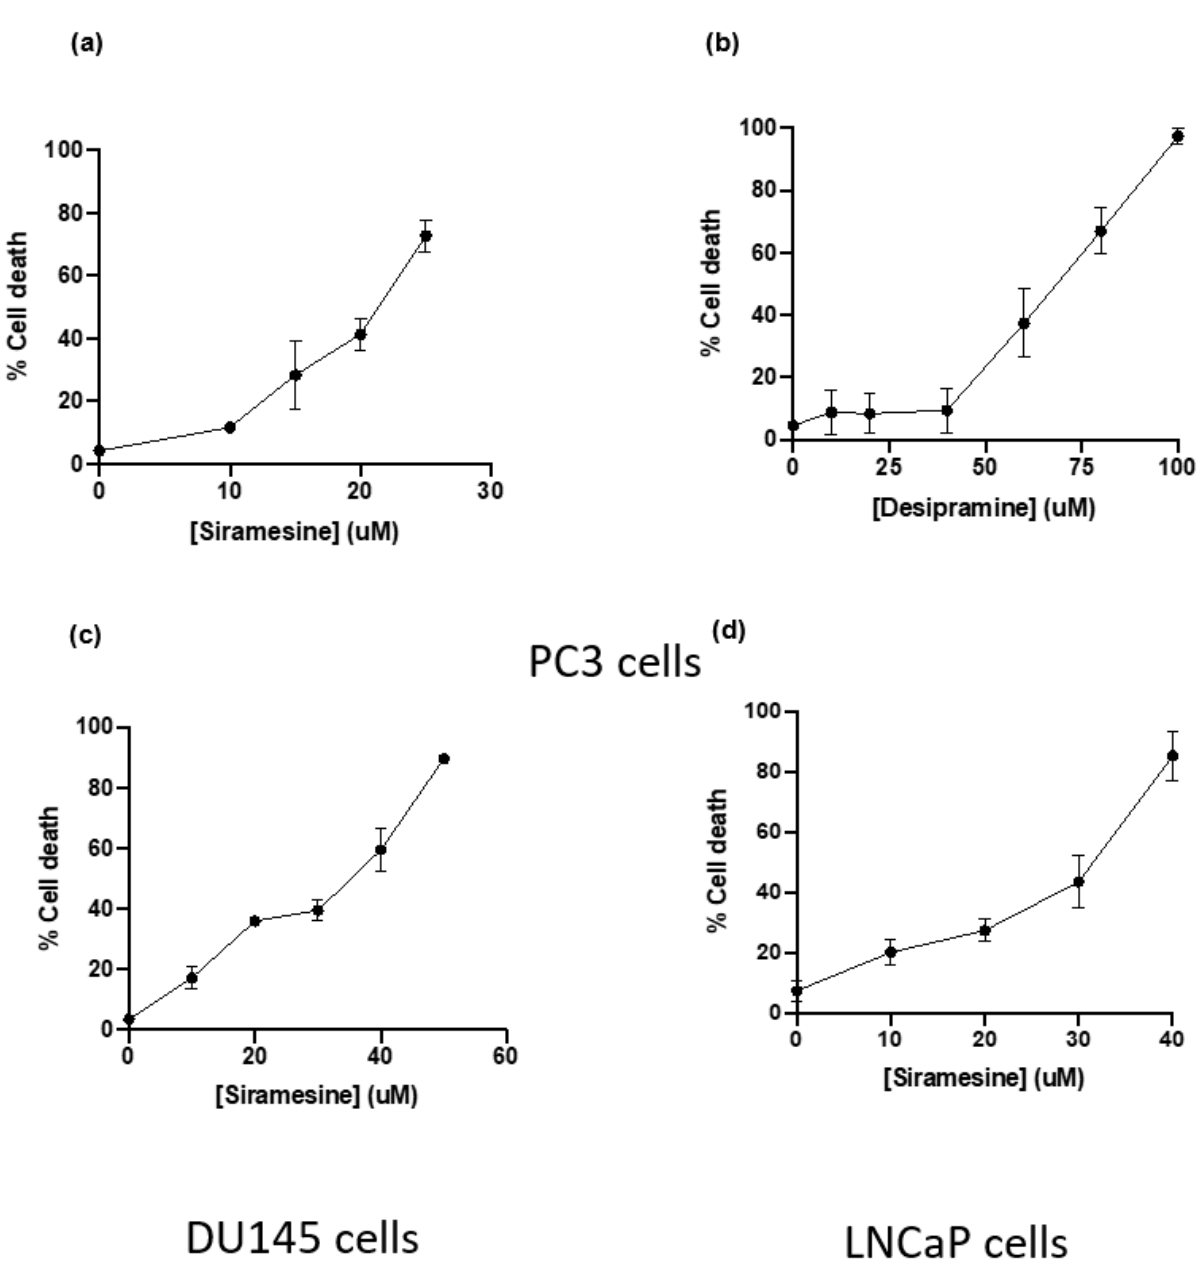
Figure 3. Siramesine and desipramine induced cell death after 24 h treatment. PC3 cells were treated with ( a ) siramesine and ( b ) desipramine for 24 h and stained with the fluorescent dye Trypan blue (0.4%) and analyzed by flow cytometry. An increase in fluorescence indicates an increase in cell death. Results are representative of at least three independent replicates ( n = 3). ( c ) DU145 and ( d ) LNCaP cells were treated with increasing doses of siramesine for 24 h and stained with the fluorescent dye Trypan blue (0.4%) and analyzed by flow cytometry. An increase in fluorescence indicates an increase in cell death. Results are representative of at least three independent replicates ( n = 3).